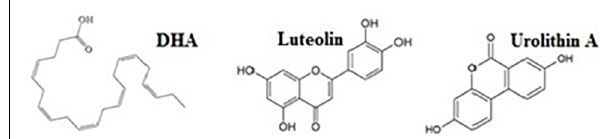
FIGURE 1 | The compounds of interest. The compounds investigated in the present study were, omega-3 polyunsaturated fatty acid, docosahexaenoic acid (DHA) and pomegranate-derived compounds: luteolin (LUT), urolithin A